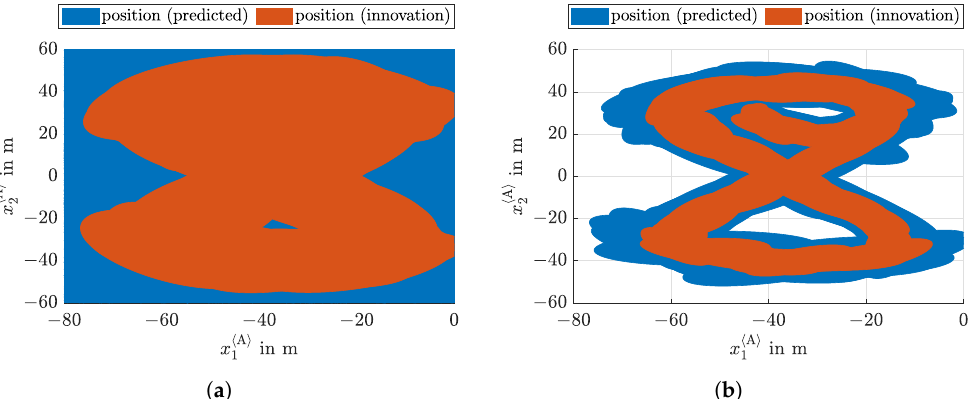
Figure 9. Localization of the DDboat A with heading and velocity measurement, reduced number of measurements. ( a ) Evaluation of the system matrix in (55) for estimated heading information. ( b ) Evaluation of the system matrix in (55) for measured heading